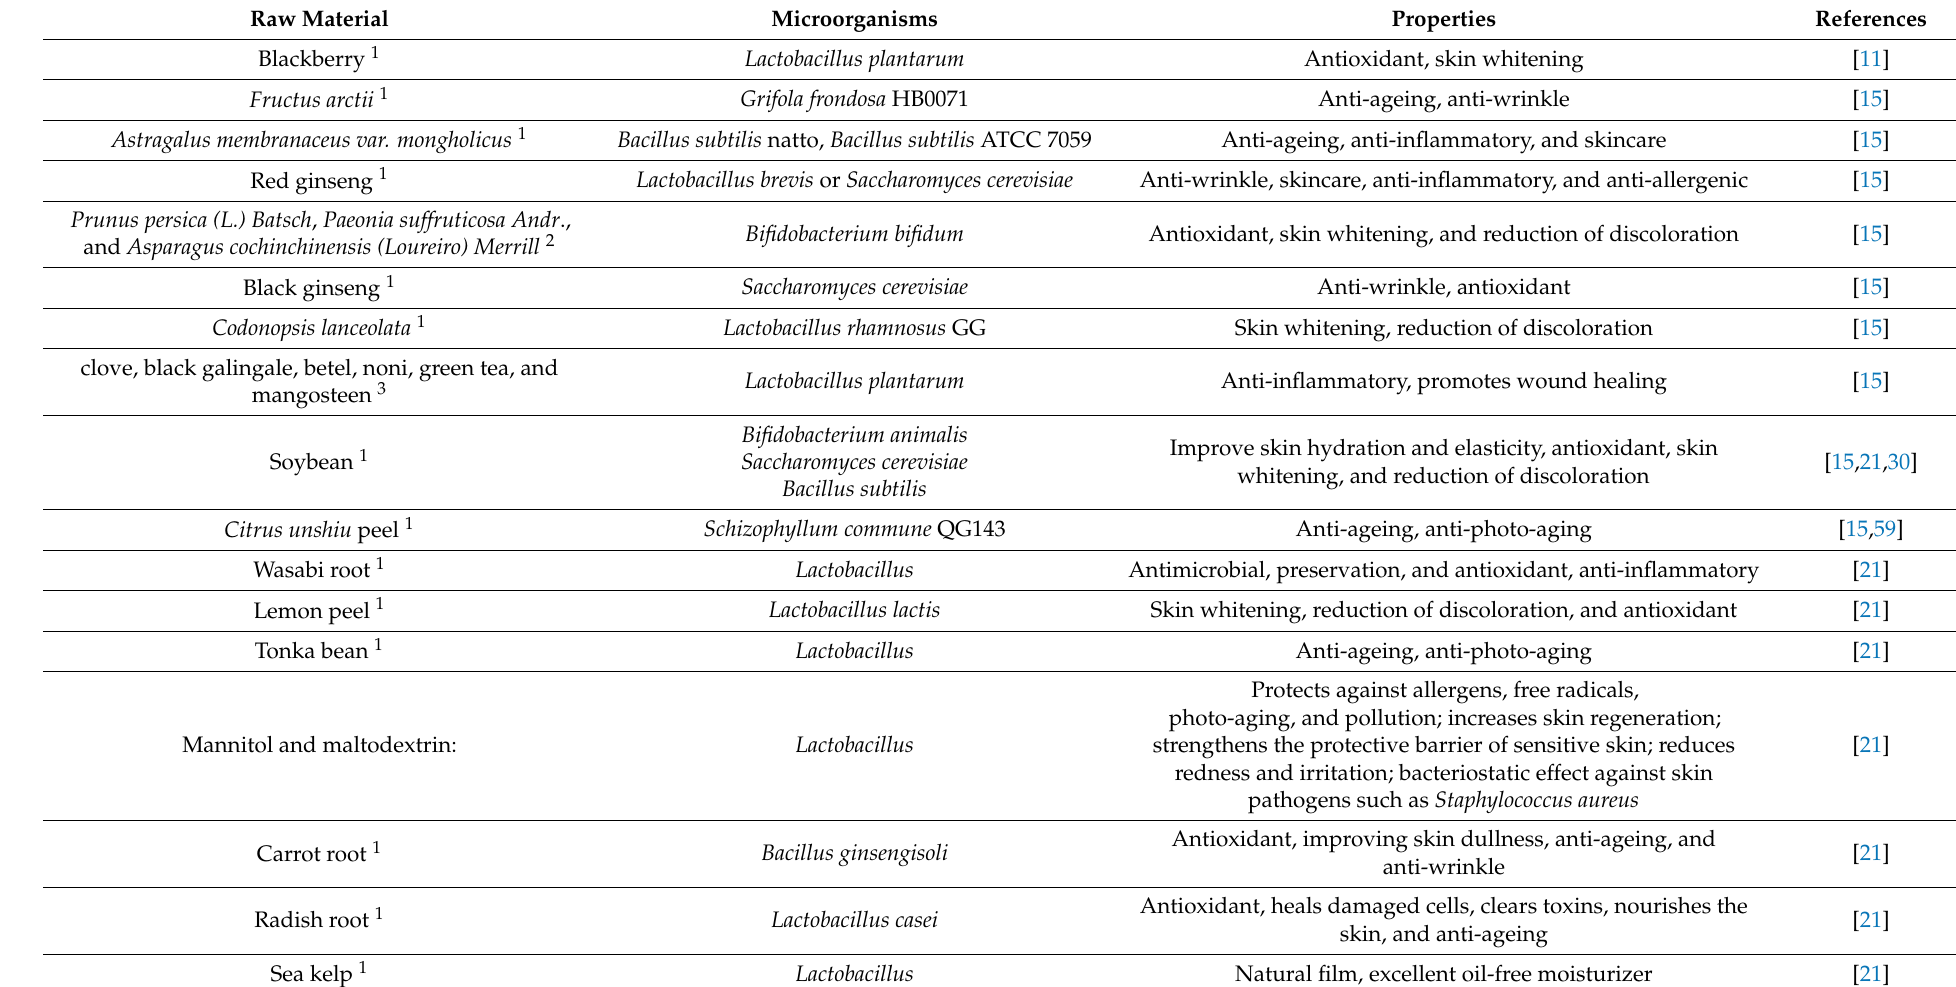
Table 1. An overview of fermented raw materials with cosmetic